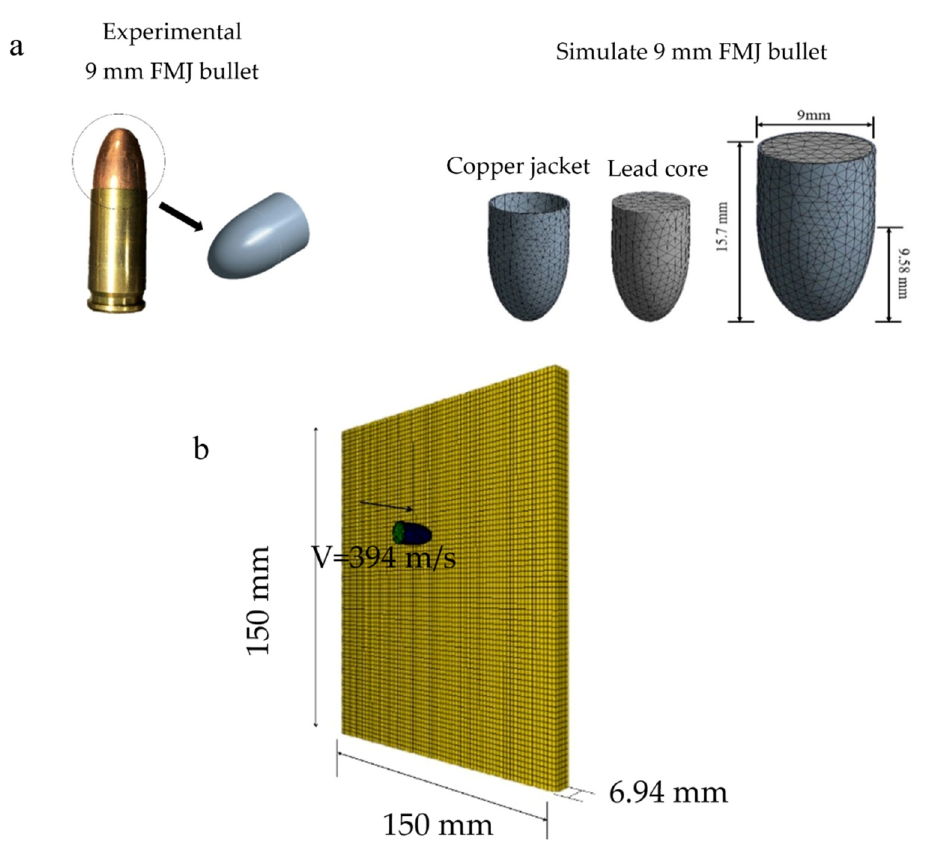
Figure 1. The geometries for ( a ) the 9 mm full metal jacketed (FMJ) bullet, and ( b ) the nanocomposite specimen.